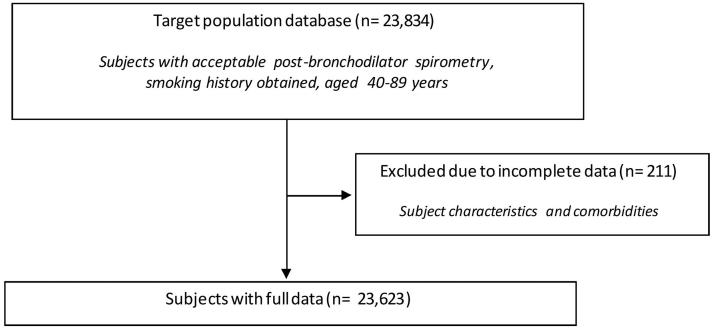
Flow chart of data extraction.